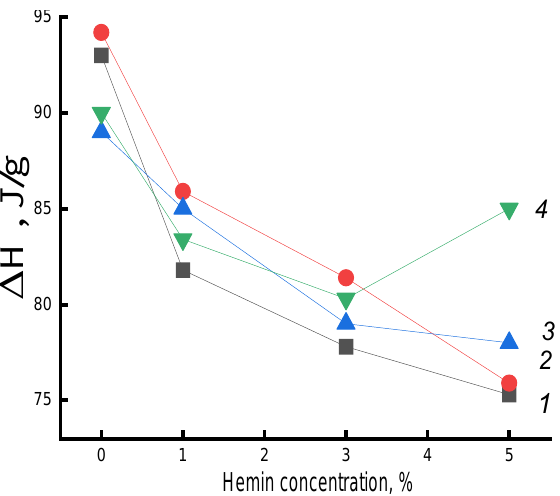
Figure 5. Dependence of the enthalpy of melting Δ H on the composition of the system for PHB fibers with hemin. Exposure time in the aquatic environment at 70 °C: 1 — 0, 2 — 30, 3 — 90, 4 — 300 min.